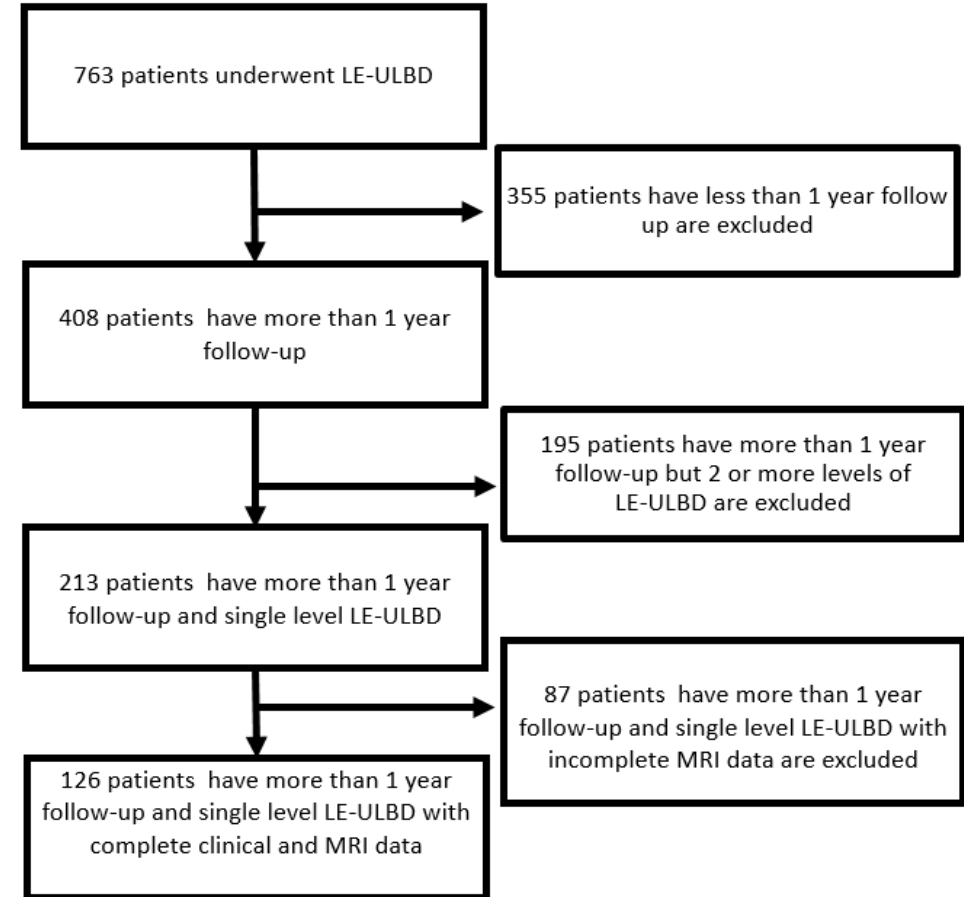
Figure 3. Flowchart of the number of included and excluded patients.